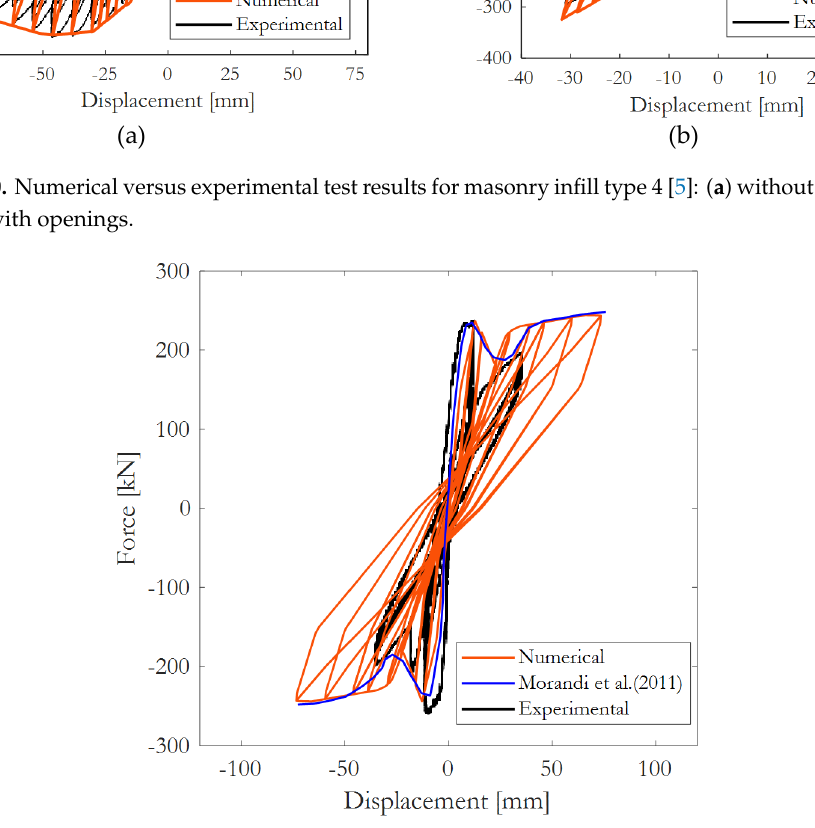
Figure 11. Numerical versus experimental test results for masonry infill type 1 [4]. Table 4. Summary of the best numerical modelling approach adopted to define the strut’s hysteretic behaviour for each masonry infill